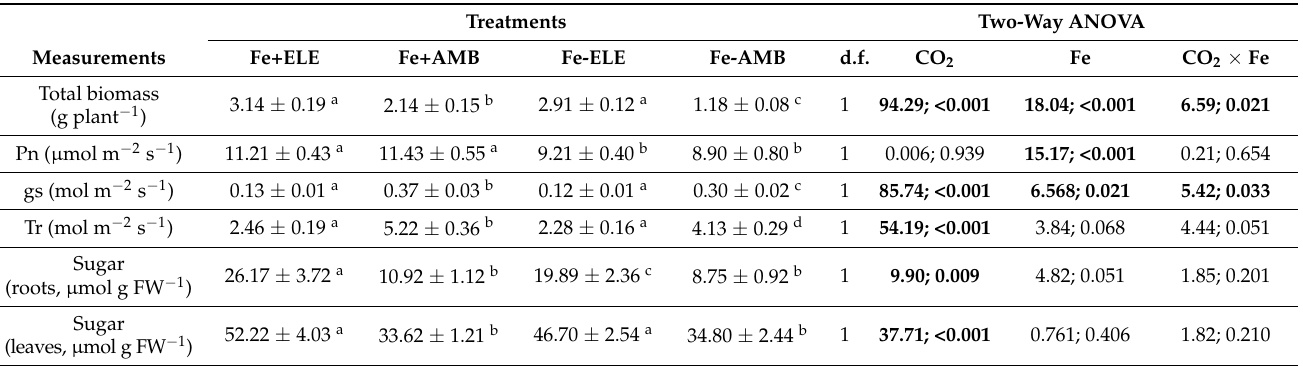
Table 1. Effects of eCO 2 and Fe-limitation on biomass, sugar content, and gas exchange parameters in soybean